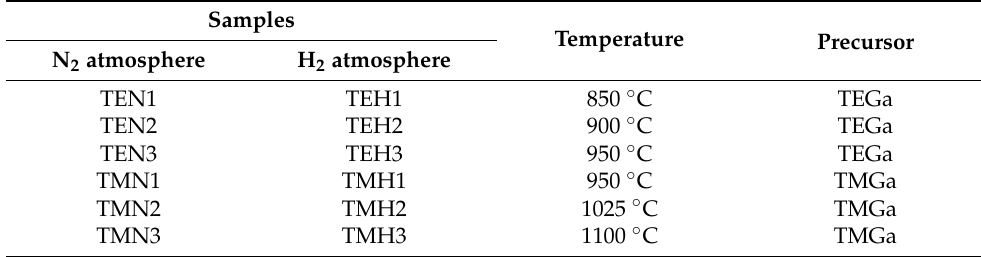
Table 1. Technological growth conditions of samples prepared for VEPAS measurement.